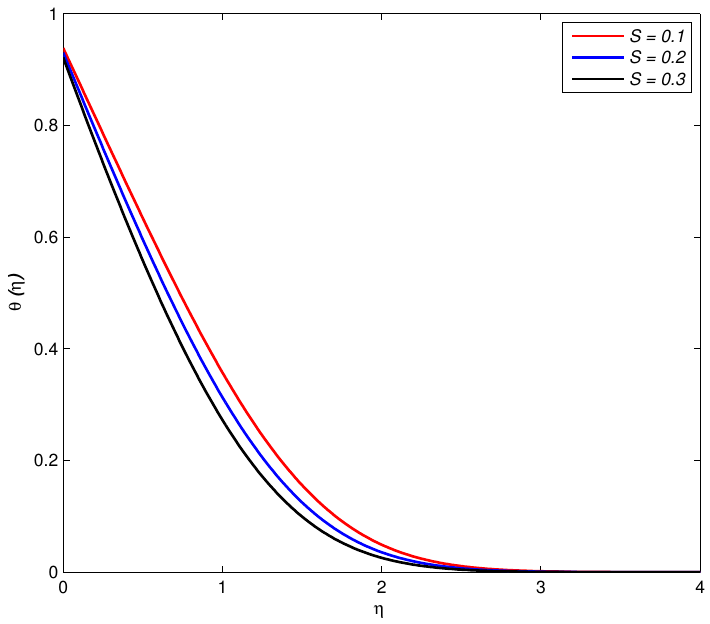
Figure 15. Temperature θ ( η ) profiles for different values of suction parameter S > 0.